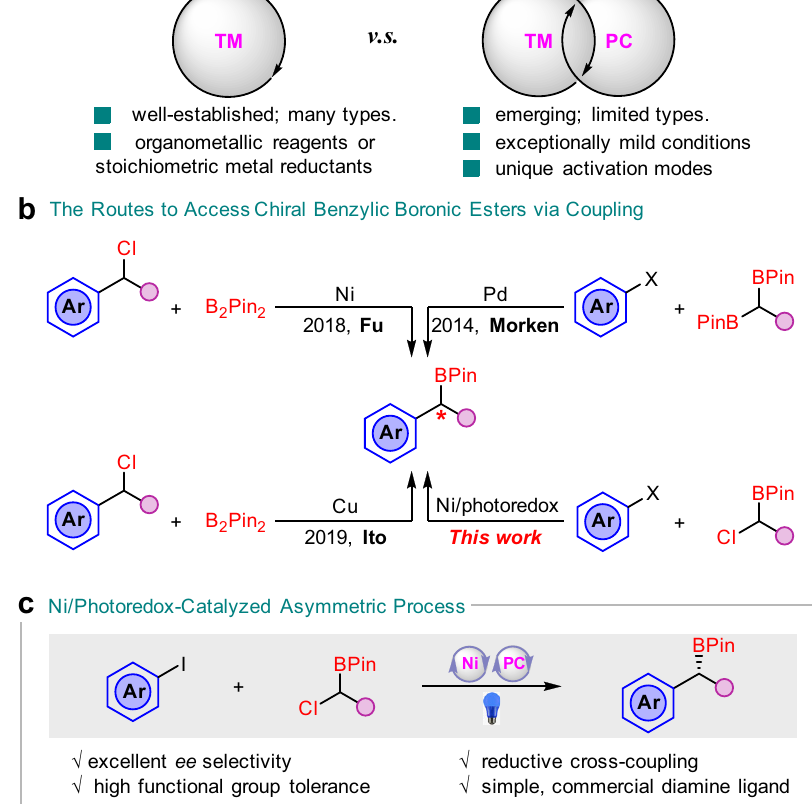
Fig. 1 TM-catalyzed asymmetric cross-couplings. a Catalytic modes on asymmetric cross-coupling. b The routes to access chiral benzylic boronic esters via coupling. c Ni/photoredox-catalyzed asymmetric process. (TM: transition metal; PC: photoredox